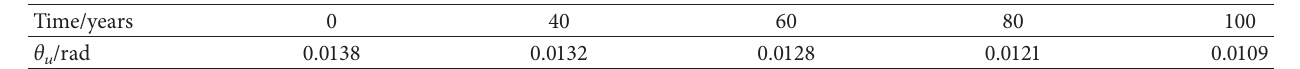
Figure 5: Pile reinforcement diagram (unit:mm). Table 5: Maximum permissible turning angles over